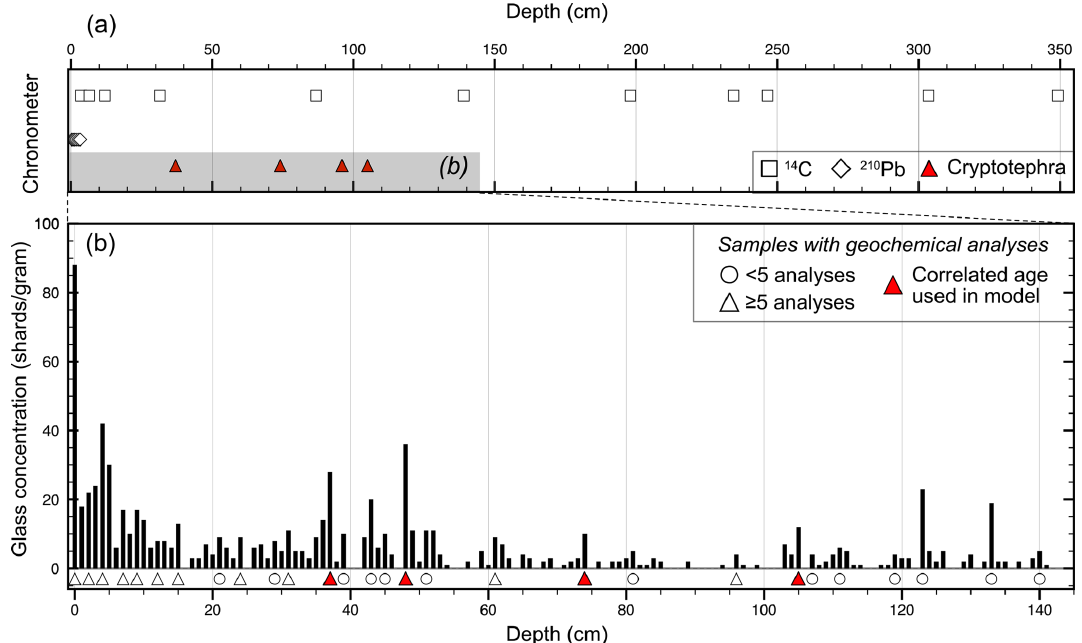
Figure 2. Cascade Lake core CASC-4A/2D chronological controls. (a) The composite depths of radiometric ages ( 14 C and 210 Pb; Table 1) and correlated cryptotephra ages (Tables 2a and 3). The shaded grey area shows the depth interval of core sampled for cryptotephra analysis (expanded in panel b ). (b) Glass shard concentration counts produced down to 1.42m, and the composite depths of analysed glass peaks. Geochemical analysis was carried out for 28 of the 142 samples: circles: < 5 points analysed; triangles: > 5 points analysed; filled red triangles have correlated ages that are used in the age–depth